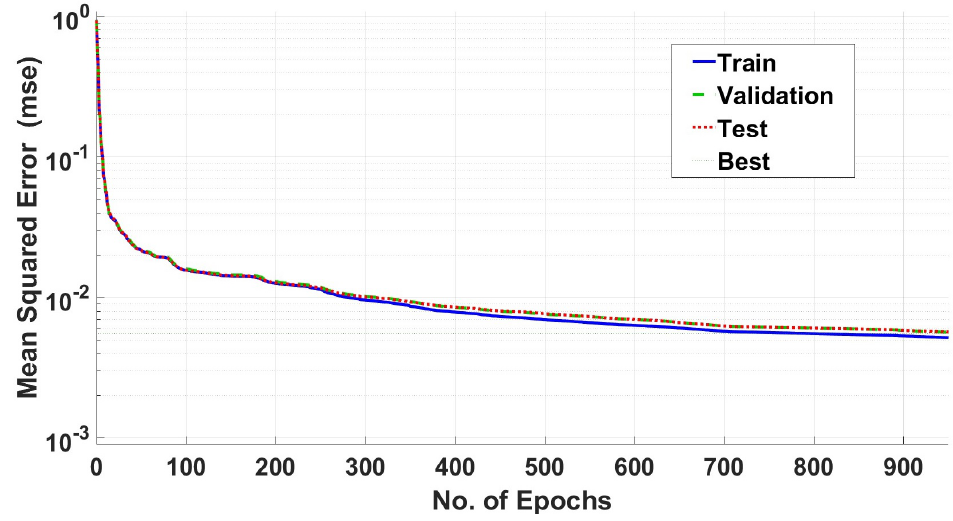
Figure 6. Training performance of BR algorithm.